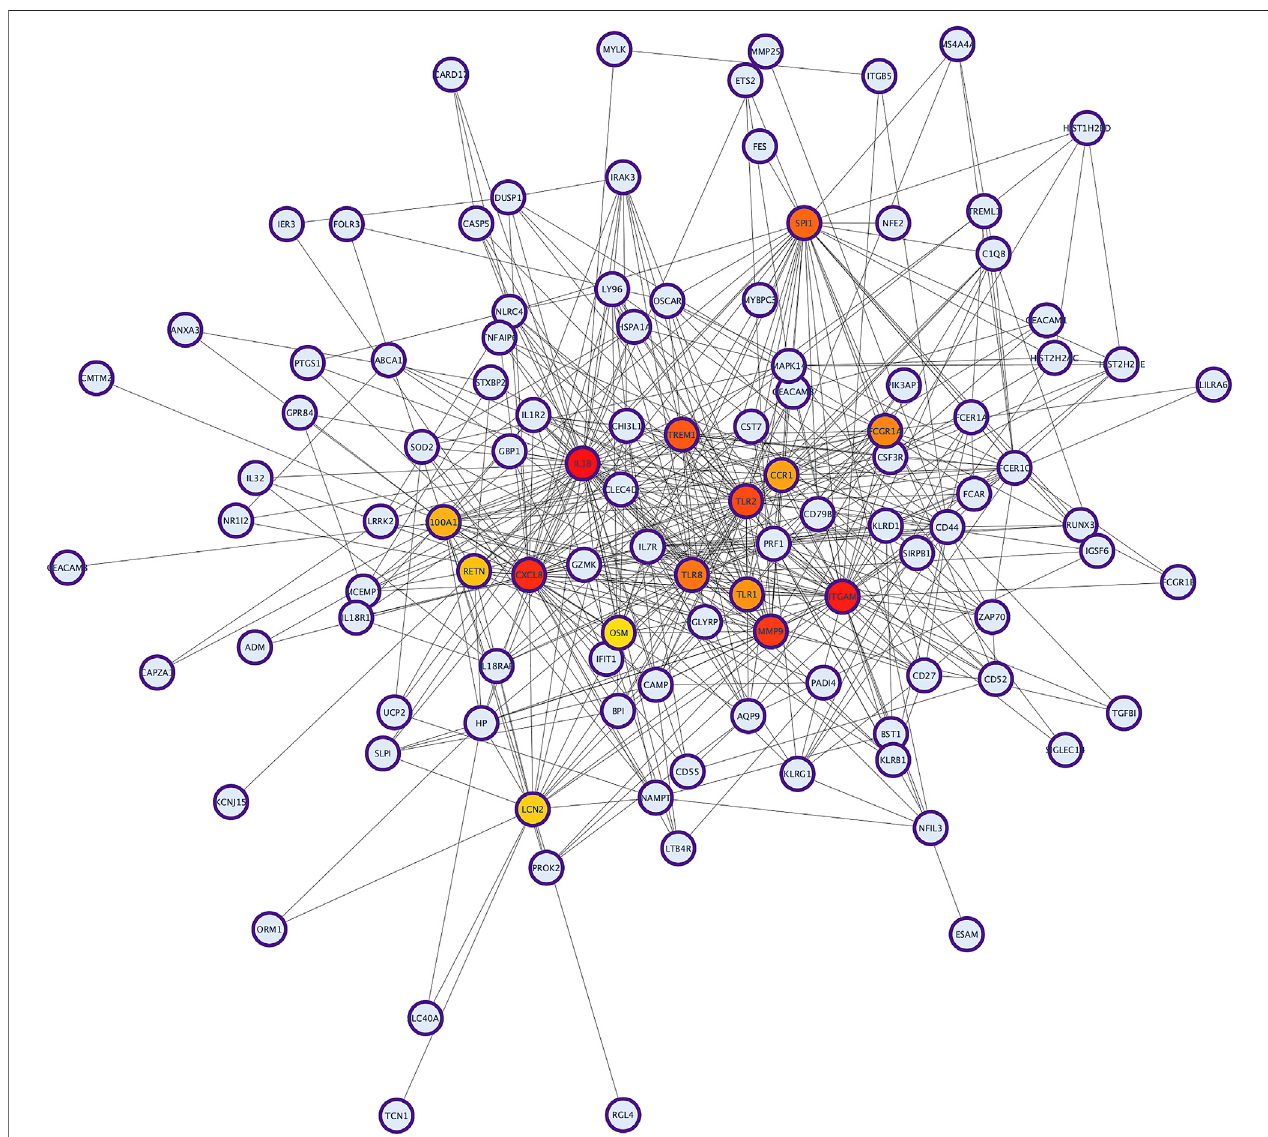
FIGURE1| Theprotein – proteininteraction(PPI)networkanalysisofdifferentiallyexpressedgenesinKD.ThenetworkwasconstructedbyCytoscapebasedonthe PPI correlations from the STRING database.